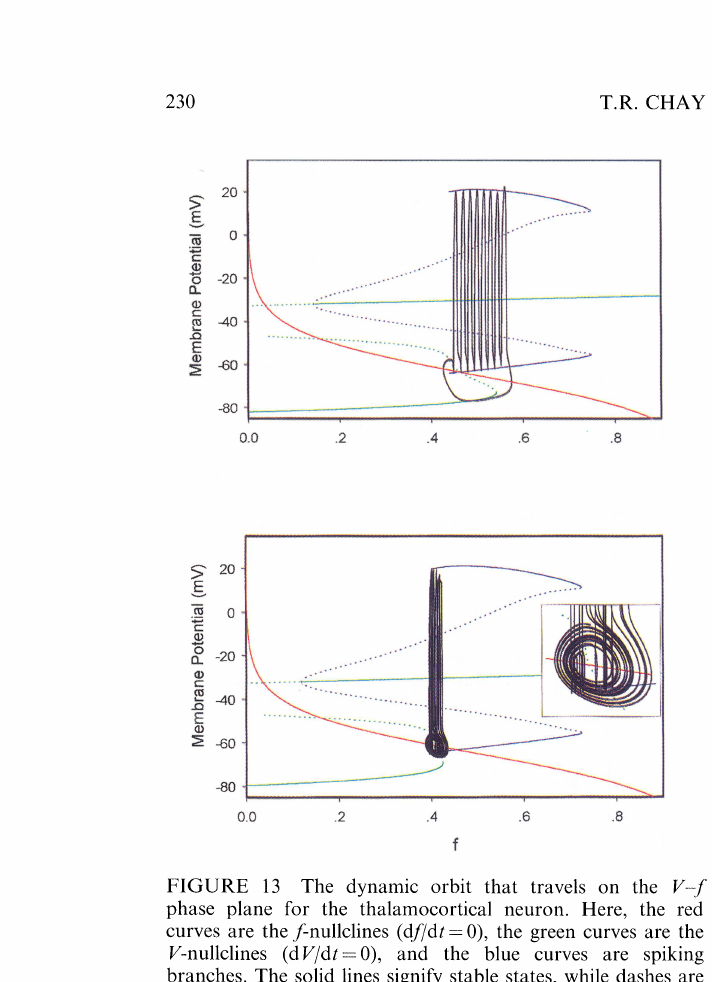
FIGURE 13 The dynamic orbit that travels on the V-f phase plane for the thalamocortical neuron. Here, the red curves are the f-nullclines (df/dt-O), the green curves are the V-nullclines (dV/dt=O), and the blue curves are spiking branches. The solid lines signify stable states, while dashes are unstable states. The top frame was constructed using lapp= -3.5 gA/cm 2, and the bottom frame using /app 2.07 laA/cm 2. (See Color Plate